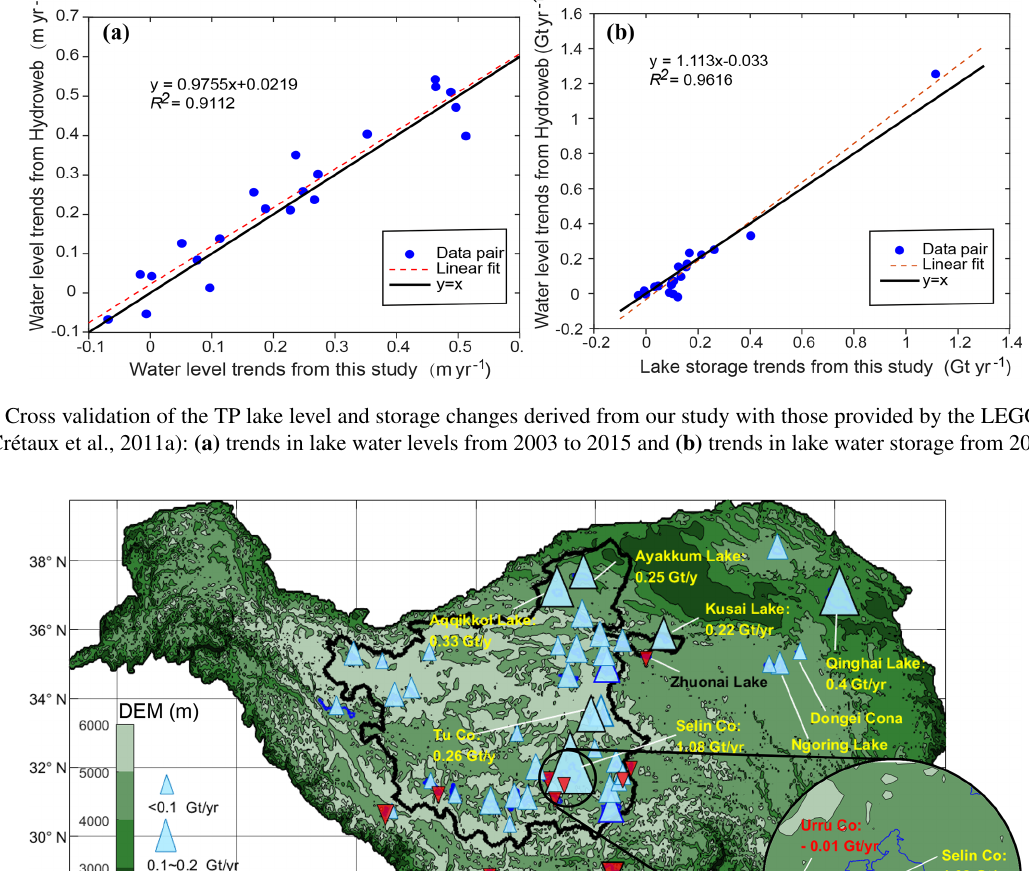
Fig. 13. The three shrinking lakes are located in the upstream region and feed Selin Co through two small rivers. One of the rivers links lakes Goren Co, Urru Co, and Selin Co, whereas the other links lakes Co Ngoin and Selin